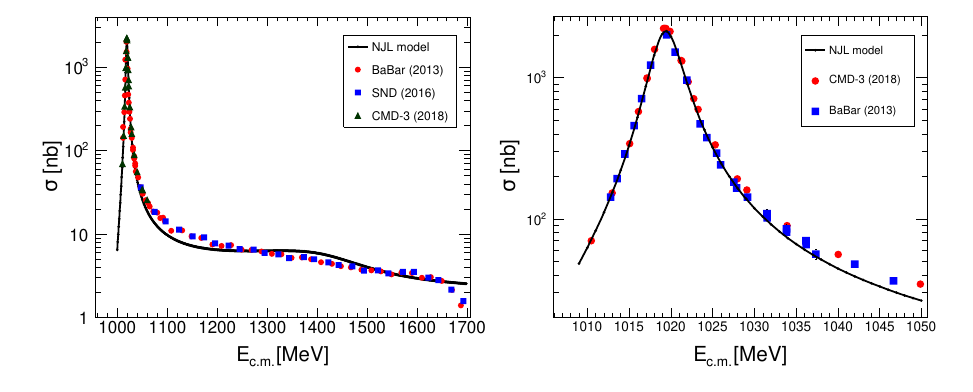
K + K − vs. center-of-mass energy. The φ meson peak region is →